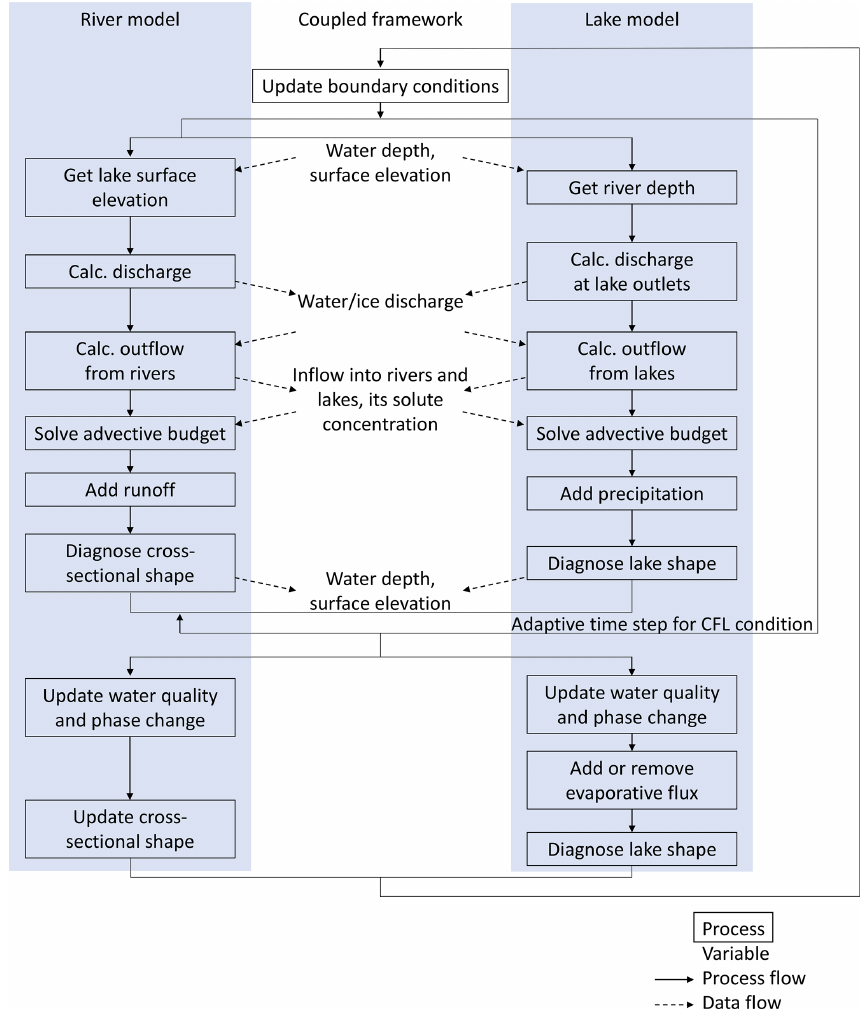
Figure 2. Flowchart of the calculation of TCHOIR. The solid (dashed) arrows indicate the order of the calculations (data exchange). The arrow branches indicate that each process can be computed in parallel, but the data exchange takes place at the same time. Table 2. List of reservoirs whose areas (km 2 ) differ by more than a factor of 2 or 0.5 between calculated and reported upstream values. The ID column provides the lake’s identifier in HydroLAKES, and the columns showing the values from the literature and the reference refer to upstream areas described in other literature from